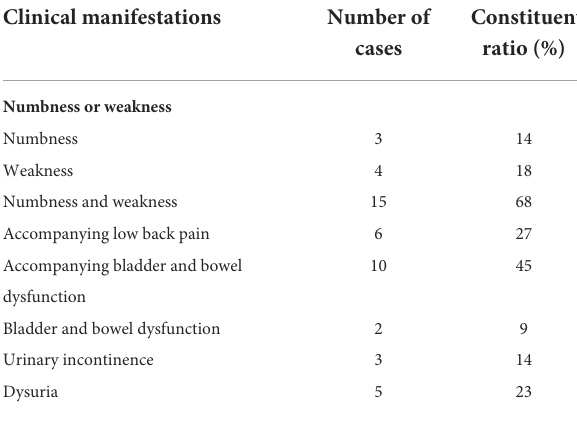
TABLE 2 Initial clinical manifestations of 22